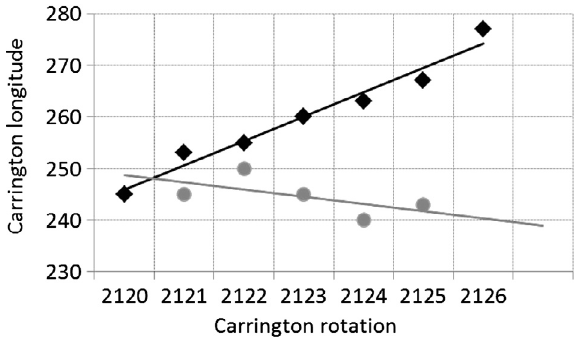
Figure 4. Longitudinal shifts of the LCH front boundary at the equator (black diamonds) and at the latitude of 30 (cid:2) N (gray circles) during CR 2120–2126. The lines represent the linear